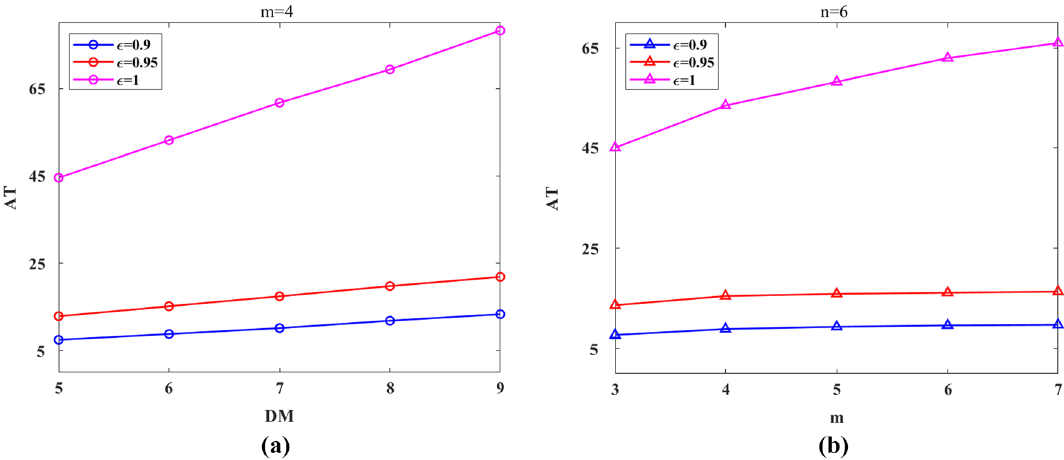
Fig. 3 Average number of iterations under different